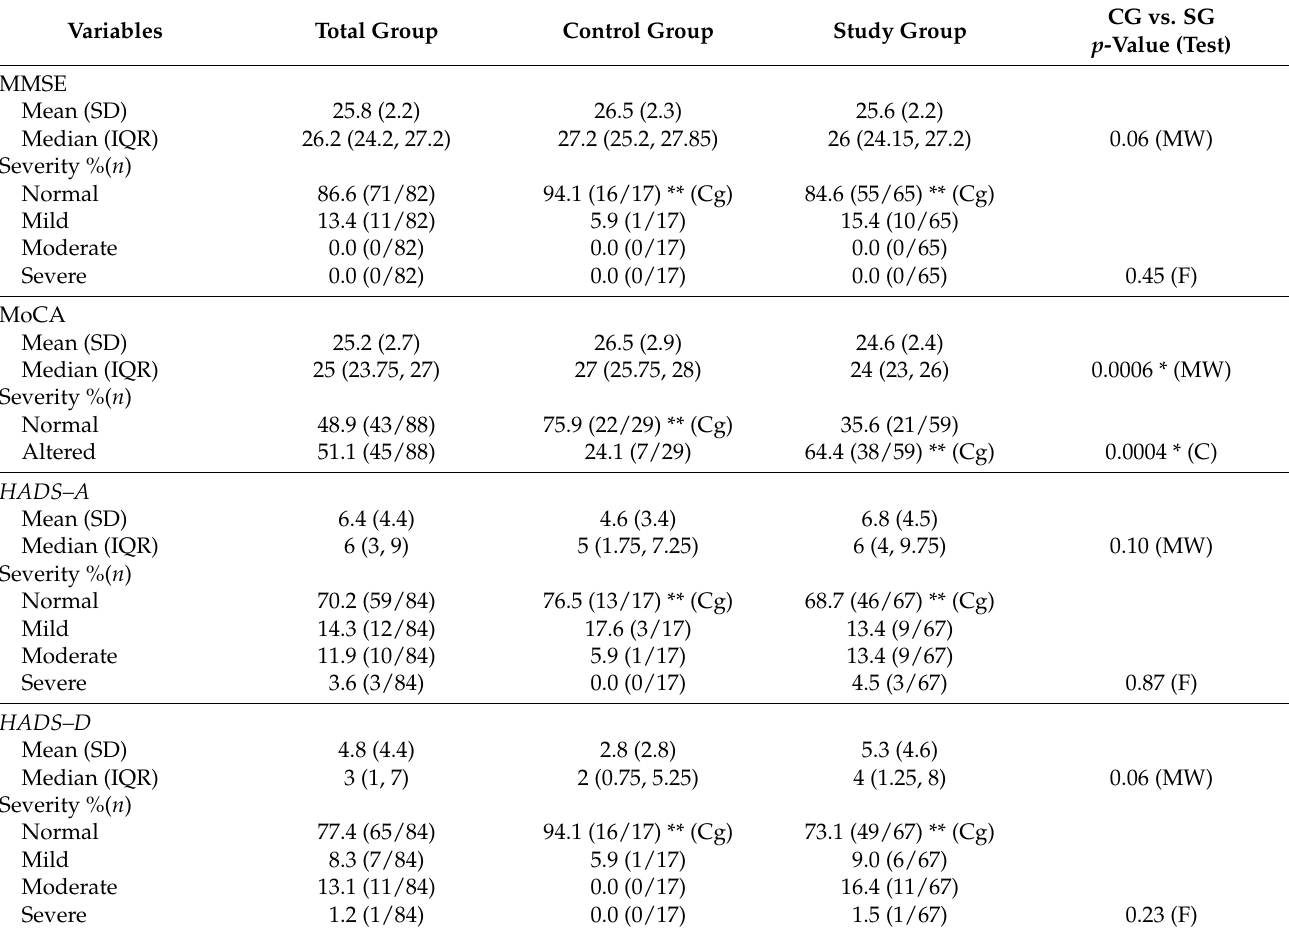
Table 4. The cognitive and neuropsychological evaluation in the study group and control